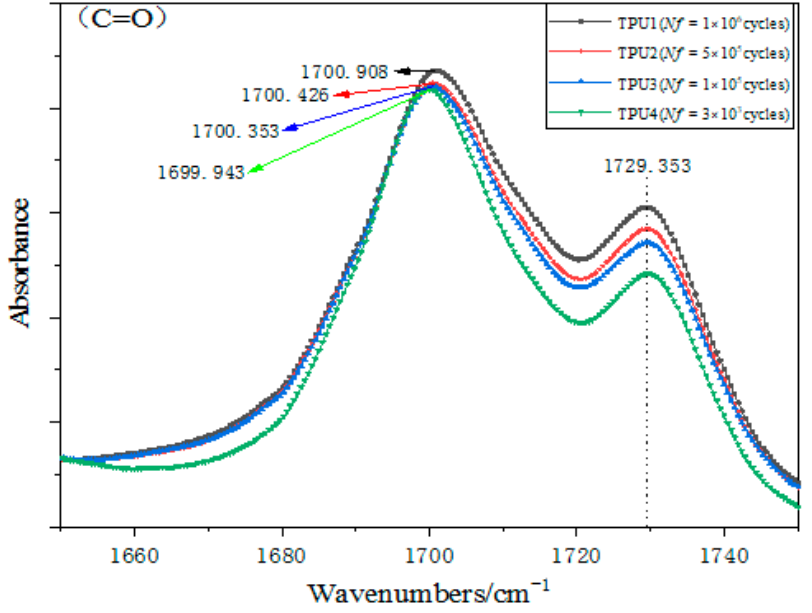
Figure 8. The change in carbonyl stretching band (C=O) of TPU samples after